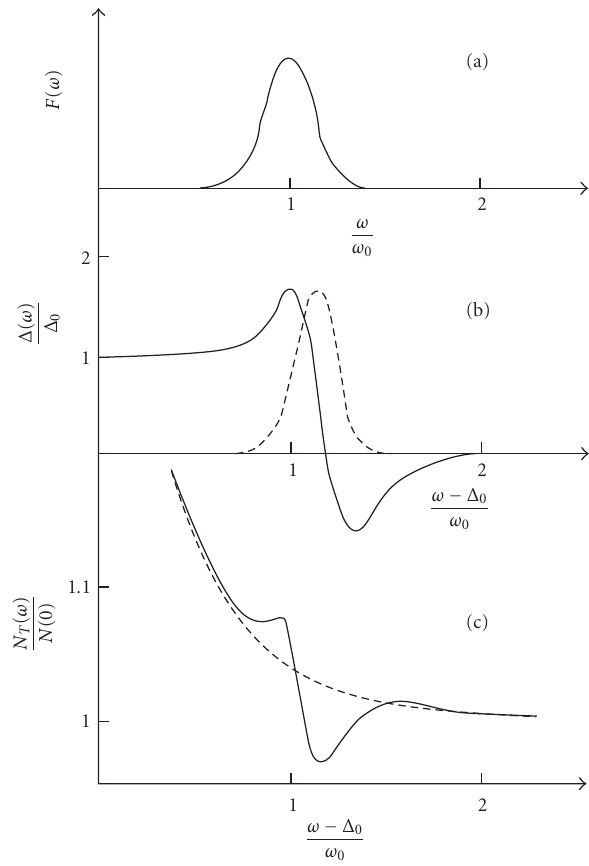
Figure 37: (a) Model phonon density of states F ( ω ) with the peak at ω 0 . (b) The real (solid) Δ R and imaginary (dashed) part Δ I of the gap Δ ( ω ). (c) The normalized tunnelling density of states N T ( ω ) /N (0) (solid) compared with the BCS density of states (dashed). From